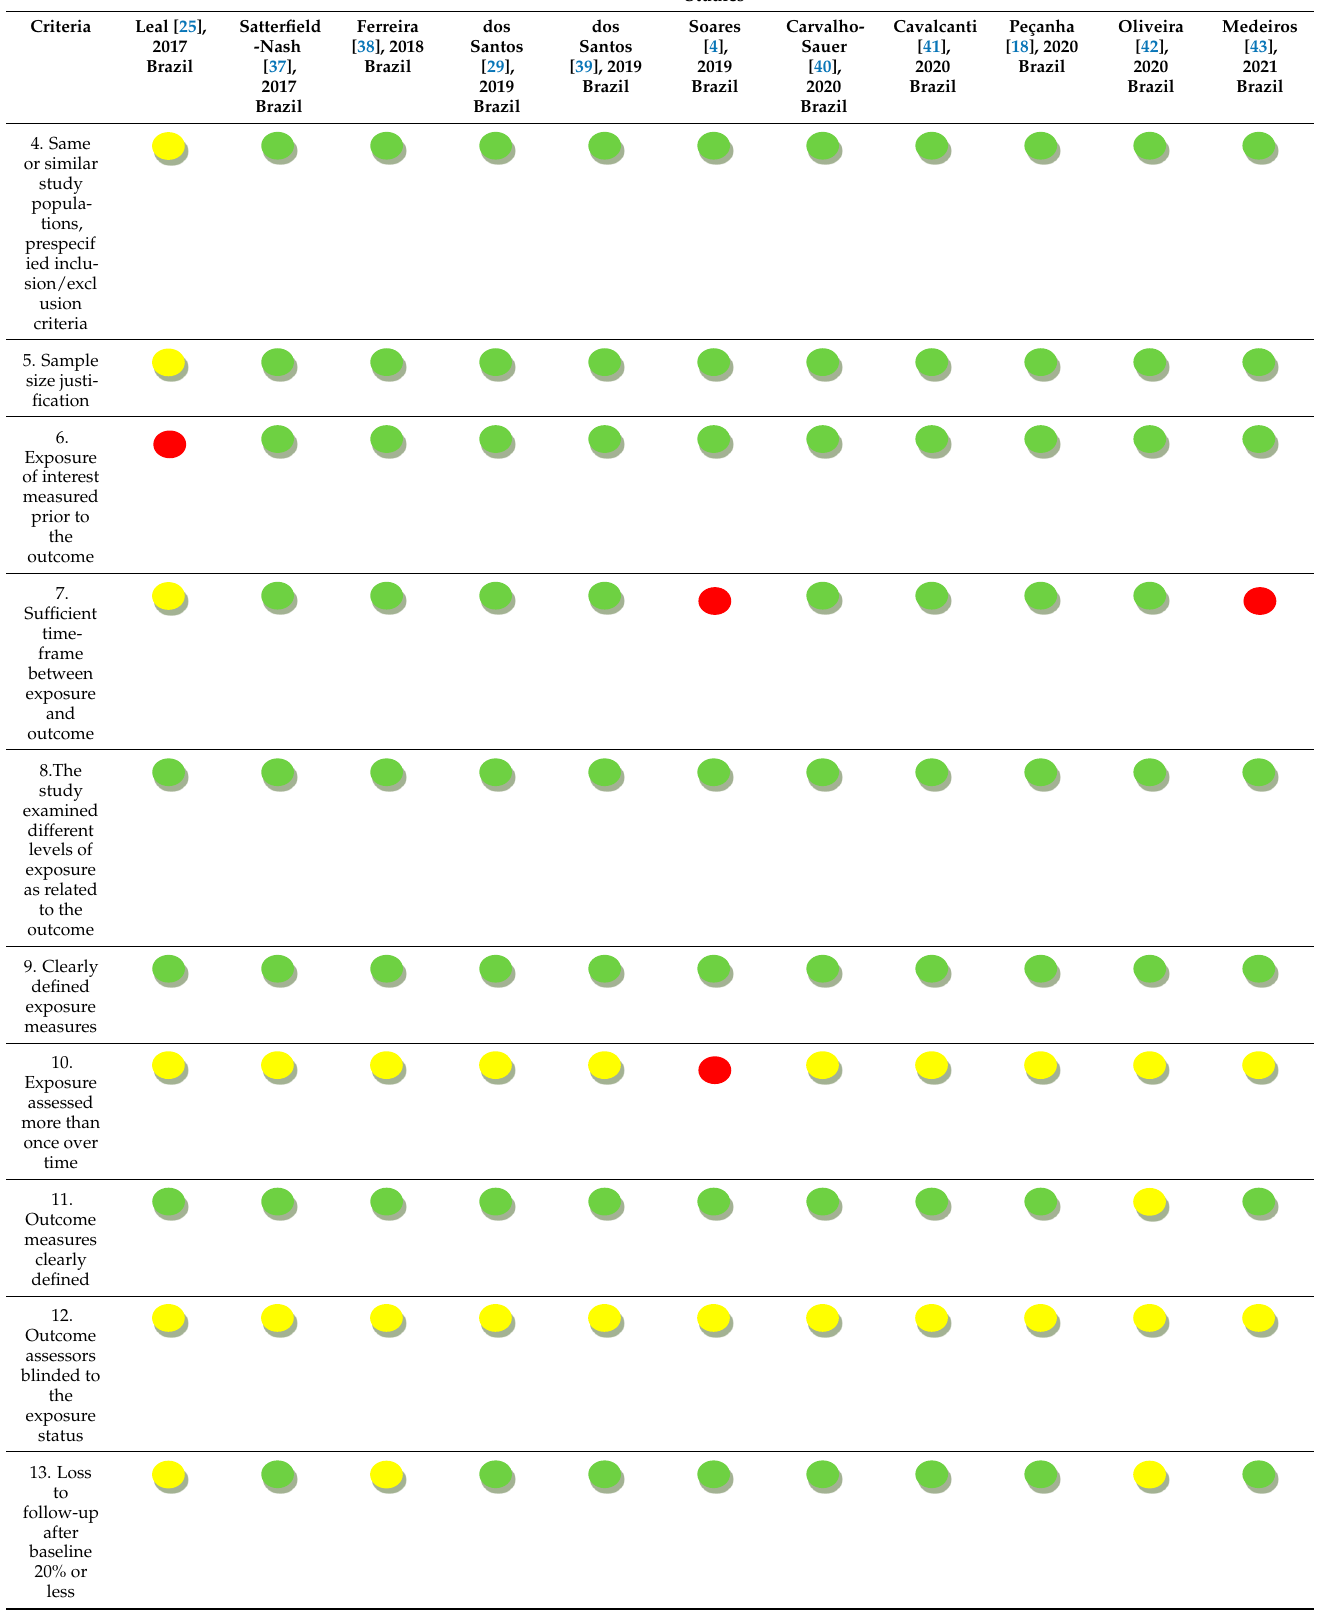
Table 1. Methodological quality and risk of bias of included articles.